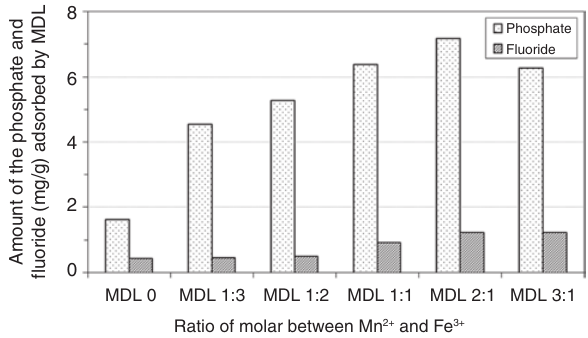
Figure 1: Influence of manganese spiking portion on the material adsorption